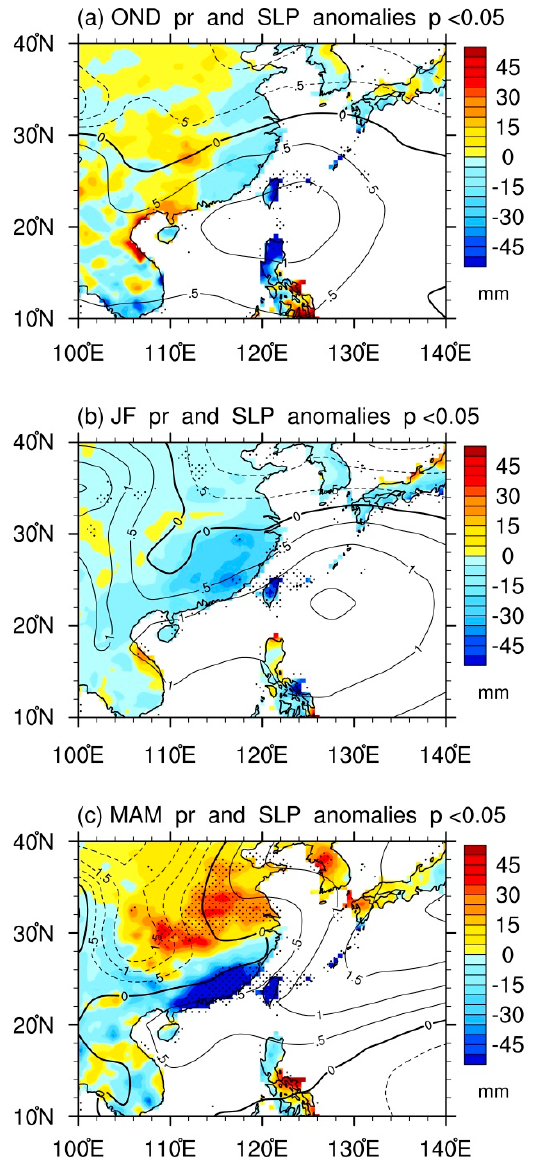
Figure 5. Composites of the severe drought cases in different seasons are shown with anomalous precipitation (colored shading; unit: mm) and SLP (contours; unit: hPa) during ( a ) OND (October to December) in 1959, 1966, 1968, 1973, 1979, 1982, 1990, 1992, 1994, 1995, 2000, 2003, and 2006, ( b ) JF (January to February) in 1955, 1960, 1963, 1969, 1974, 1977, 1987, 1991, 1996, 1999, 2002, 2004, and 2009, and ( c ) MAM (March to May) in 1955, 1960, 1962, 1963, 1964, 1967, 1969, 1970, 1971, 1977, 1986, 1991, 1995, 1999, 2002, and 2009. The dots denote areas passing 95% confidence level.